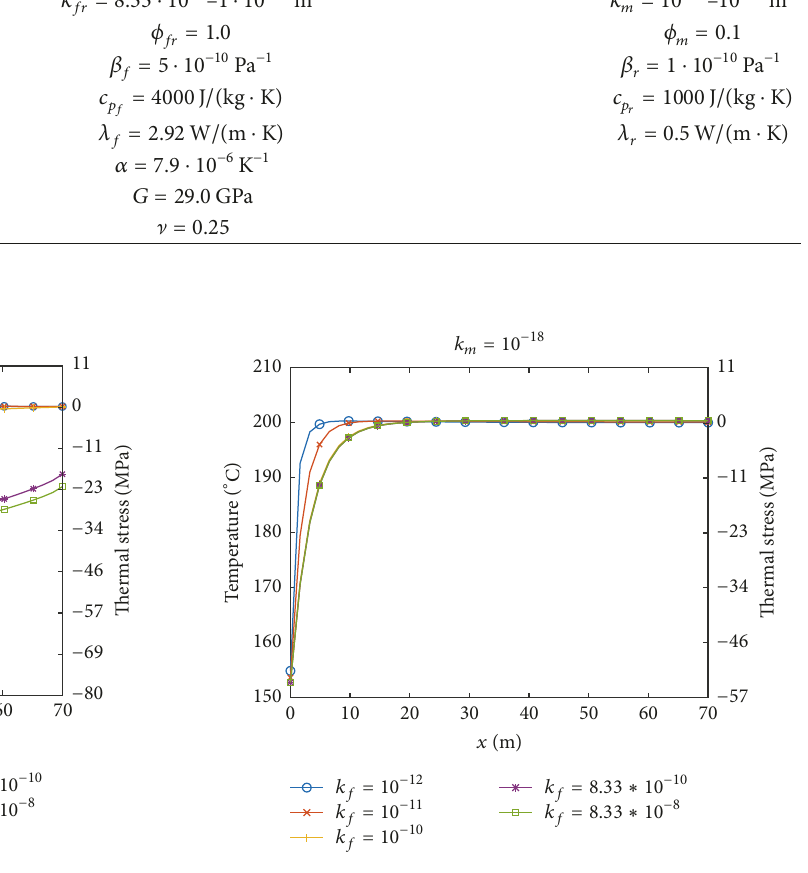
Figure4:Temperatureandthermalstressdistributionsafter30days of injection for a matrix permeability of 𝑘 𝑚 = 10 −16 m 2 .